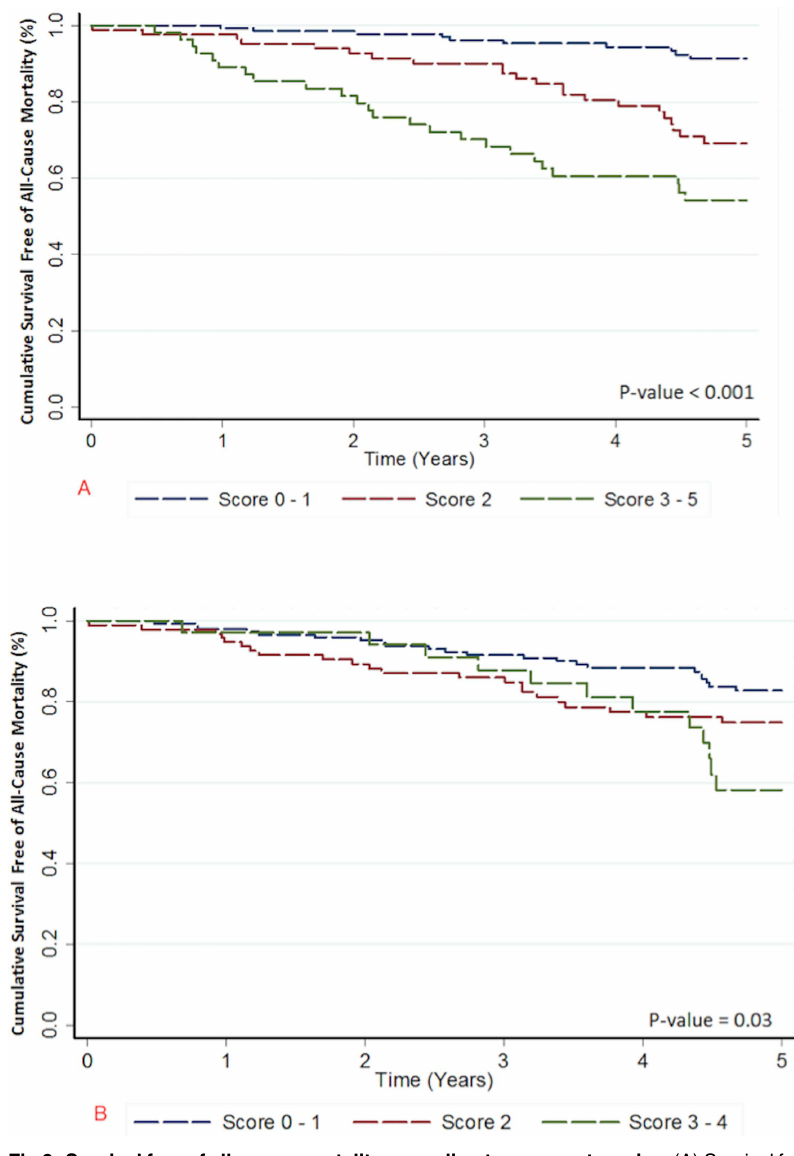
Fig 3. Survival free of all-cause mortality according to score categories. (A) Survivalfree of all-cause mortality accordingto HF hospitalization score category (B) Survival free of all-cause mortality accordingto appropriate therapy score